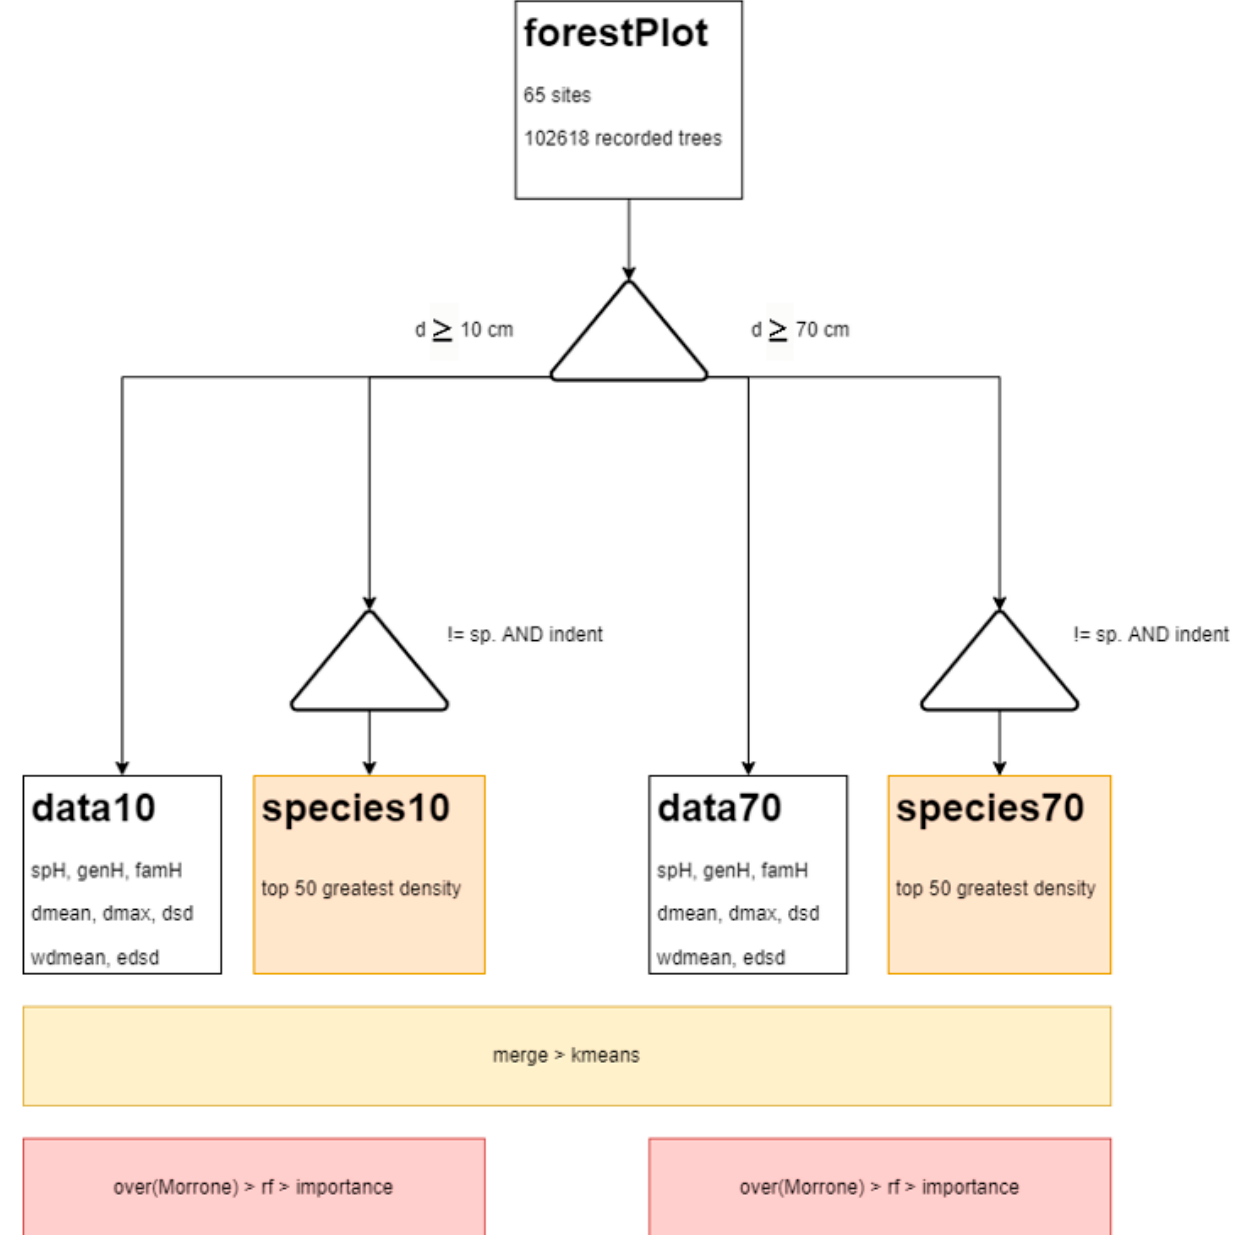
Figure 2. Processing flowchart. dmean, dmax, and dsd are the mean, maximum, and standard deviation of the diameters,